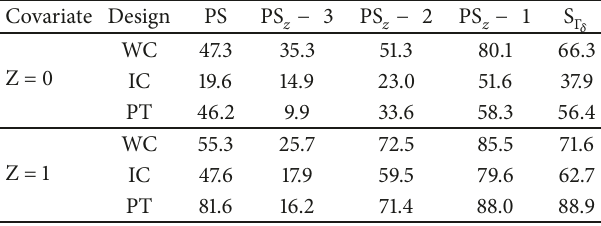
Table 4: Operating characteristics summarizing trial efficiency for 𝑍 = 0,1 with designs using covariate (WC), ignoring covariate (IC), and parallel trials (PT) considering discrete dose combinations.